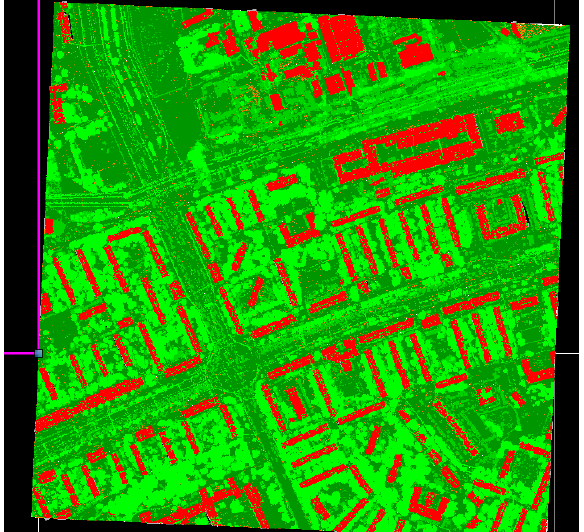
Figure 6. Automatic classification in Terrasolid.